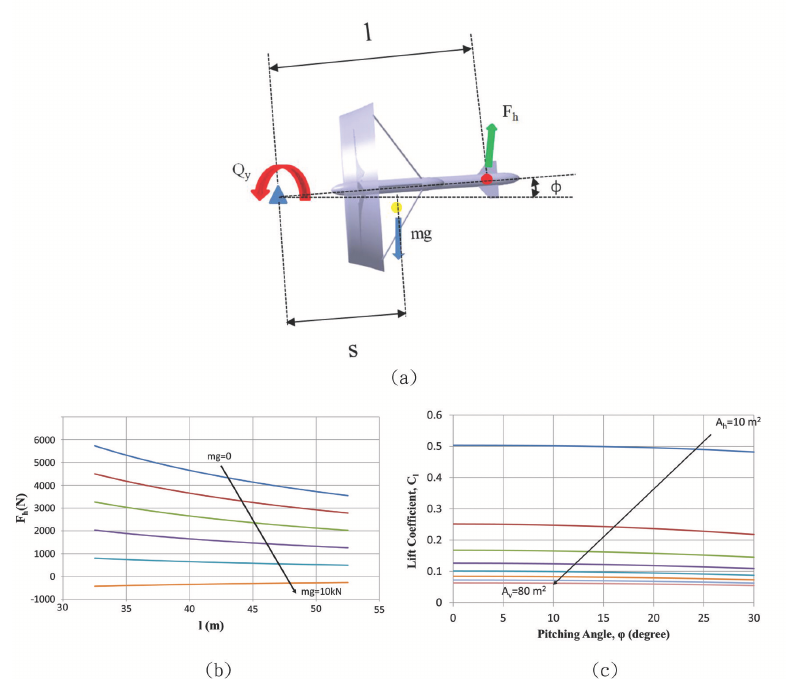
Figure 18. ( a ) Schematic for the pitching balance; ( b ) weight and force imposed on the tail fin vs. the distance from the center of the force to the anchoring point; ( c ) pitch angle and lift coefficient vs. the effective horizontal area of